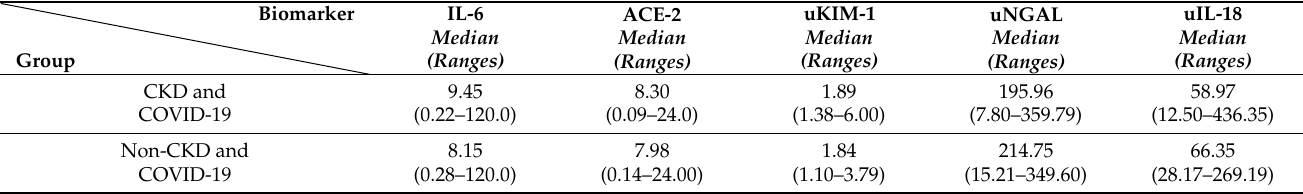
Table 2. Biomarkers by groups by median